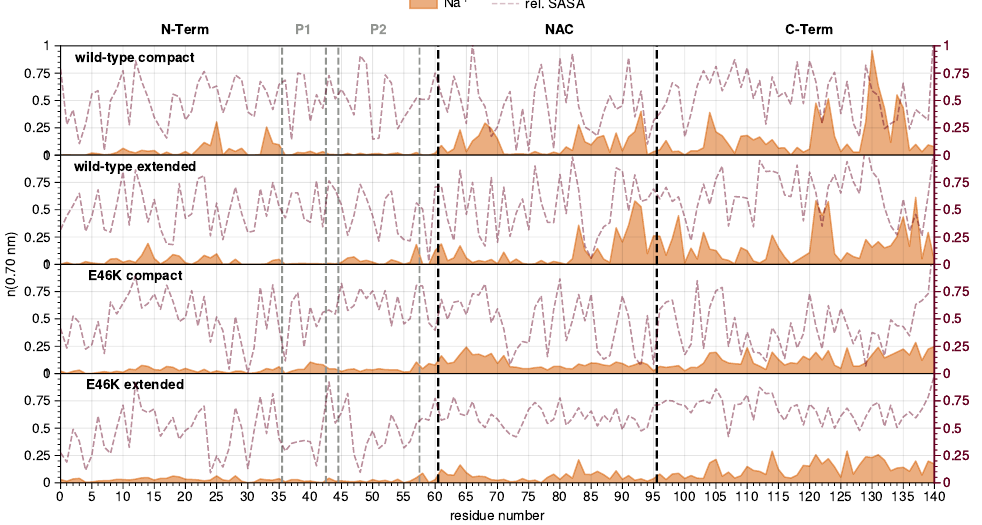
Figure 2. Chloride ion distribution along the residue index for compact and extended conformations of wild-type and E46K-AS. Residue index 0 is the acetylated N-terminus. Mean number of ions (running coordination number) is given as the integral of g ( r ) for the ion up to the second hydration shell ( r ≤ 0.70nm). Maroon lines indicate the average Relative Solvent Accessible Surface Area (RSA) for each residue (right y-axis) [89].